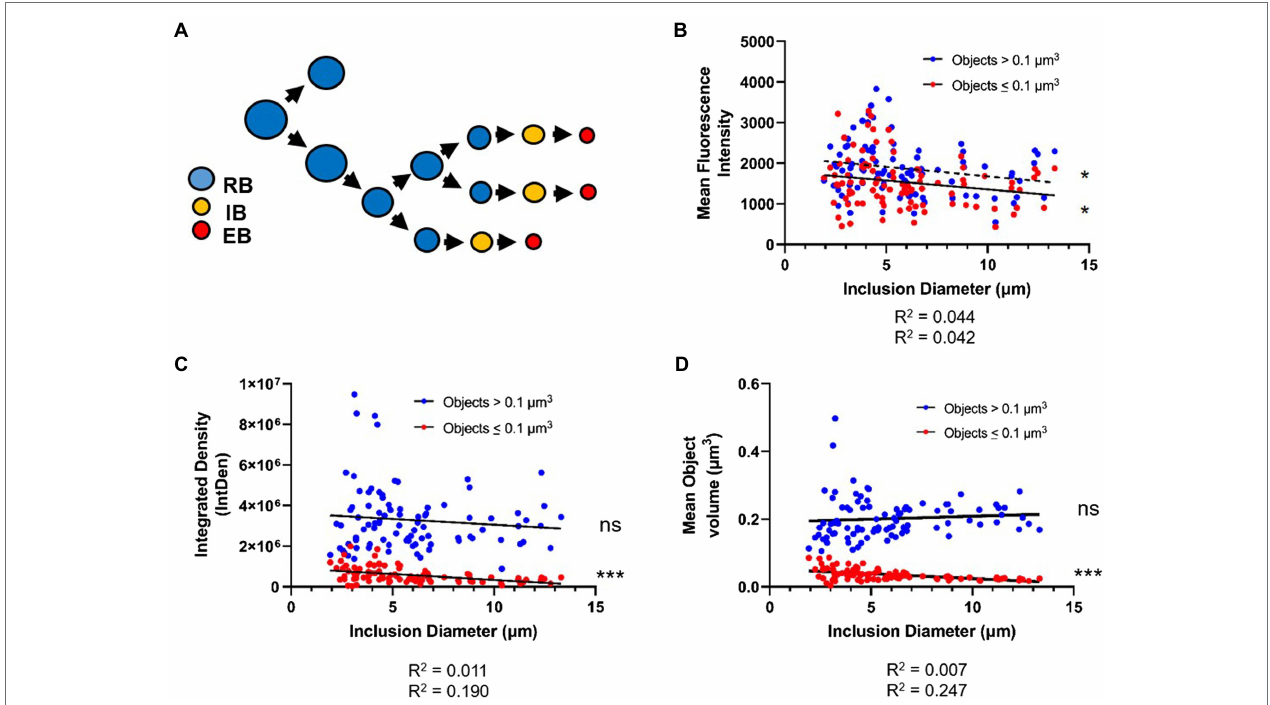
FIGURE 7 | PG-labeled object volume and mean fluorescent intensity decreases as inclusion diameter increases. (A) The cell size reduction-preceding- differentiation model, as proposed by Lee et al. The average values for PG-labeled object mean fluorescent intensity (B) , integrated density (C) , and object volume (D) were plotted against inclusion diameter. Objects in each inclusion were separated into those of “low confidence” (>0.1 μ m 3 ) and those of “high confidence” ( ≤ 0.1 μ m 3 ). Data for each object type were subjected to a linear regression analysis, and statistical analysis was performed to determine if the linear slope of the data diverged significantly from zero. ns; not significant, * p < 0.5, *** p <